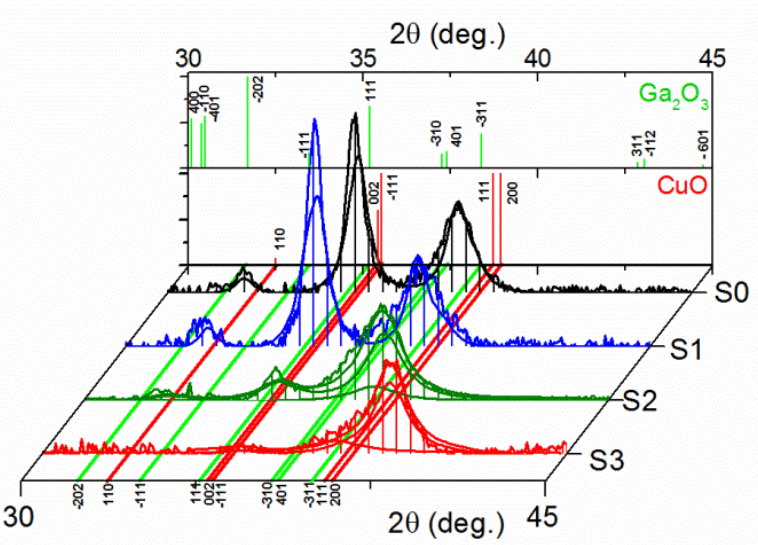
Figure 4. Di ff raction patterns of CuO:Ga samples with fits and with marked positions of Braggs maxima for bulk CuO and β -Ga 2 O 3 phases (back panel).